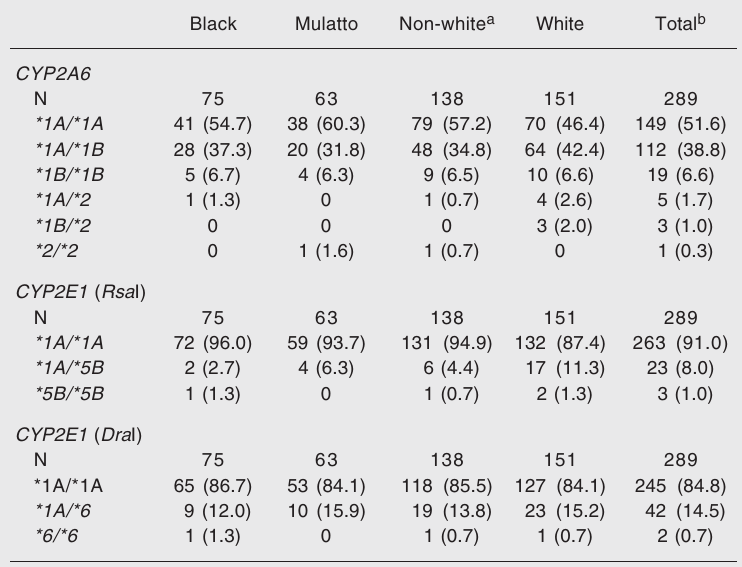
a Non-white includes mulatto and black skin-colored individuals. b Non-white (black + mulatto) and white individuals.